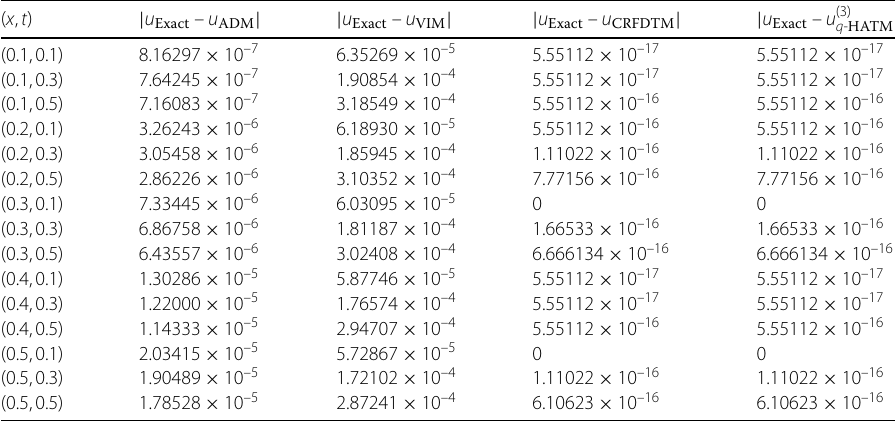
Table 1 Comparative study in terms of absolute error between ADM [28], VIM [29], CFRDTM [26] and q -HATM for the approximate solution u ( x , t ) at ω = 0.005, (cid:13) = 0.1, c = 10, n = 1, (cid:2) = –1 and α = 1 for Example 6.1